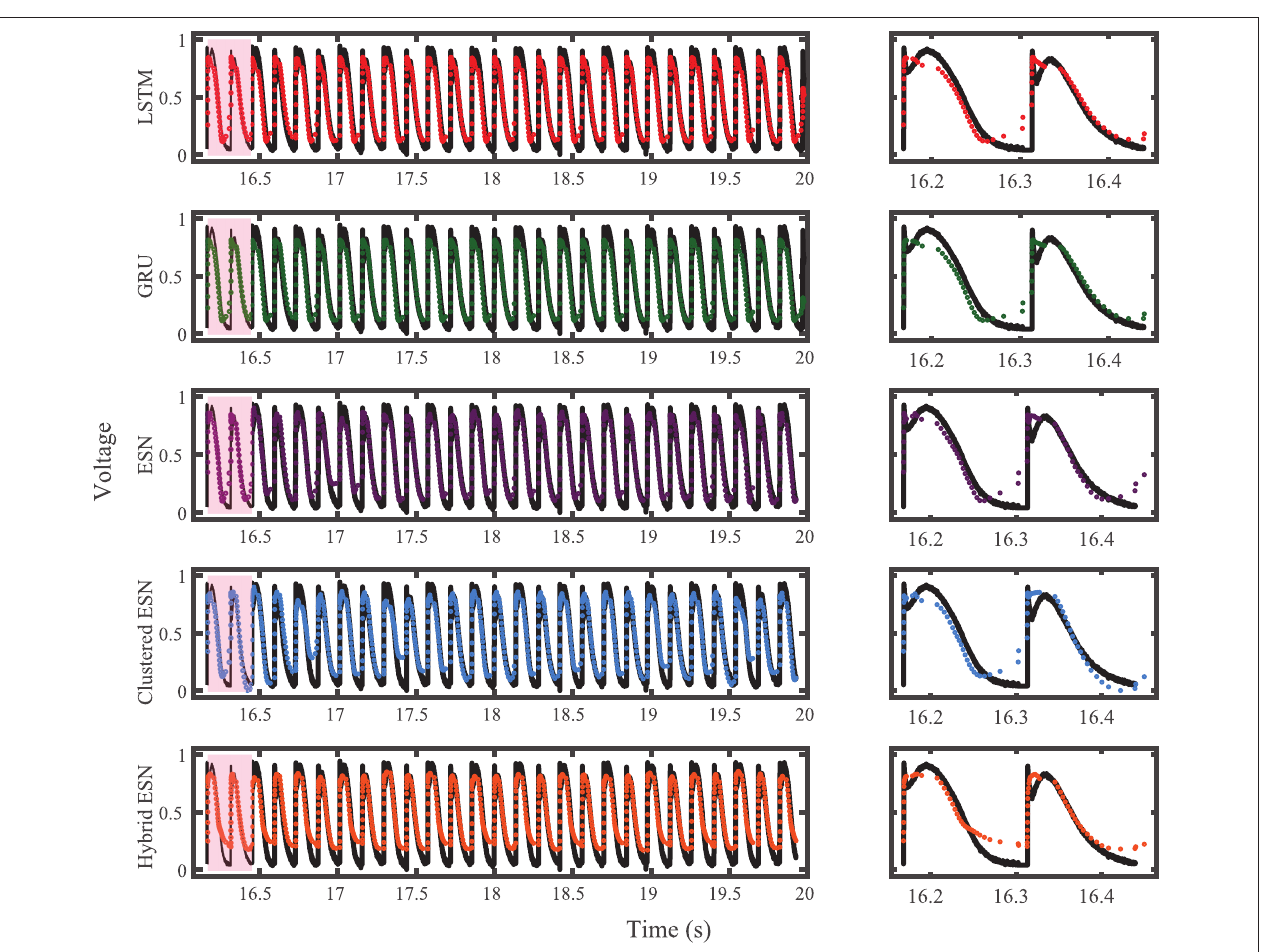
FIGURE 10 | Experimental dataset action potential prediction results obtained for the five methods using a fixed network size of 100 neurons. Test data are shown in black for reference and the predictions in color. (Left) All predicted APs. (Right) Zoomed view of the first two predicted